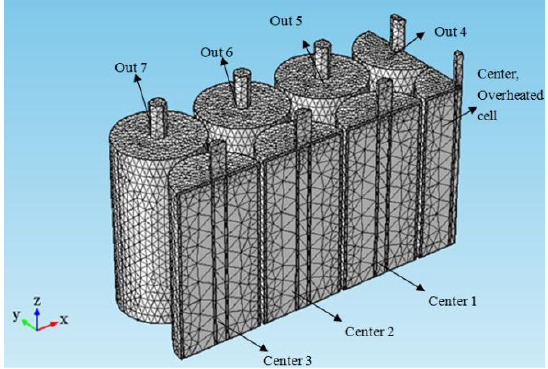
Figure 8. The geometric model of a battery module (1/8 parts) used for simulation.